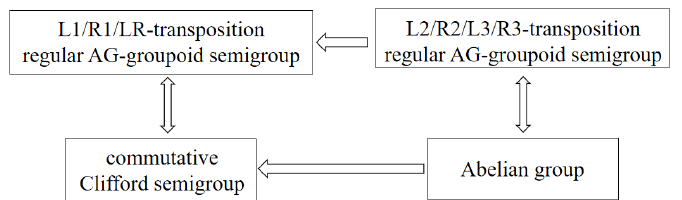
Figure 3. The relation among various transposition regular AG-groupoid